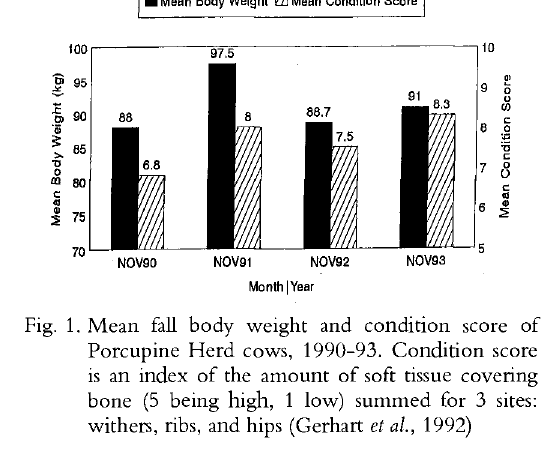
first month after birth is caused by eagles, brown bears, and wolves. Nonperinatal mortality is higher when calving is displaced into foothill and moun tain areas than when calving occurs primarily on the coastal plain where predators are scarce (Table